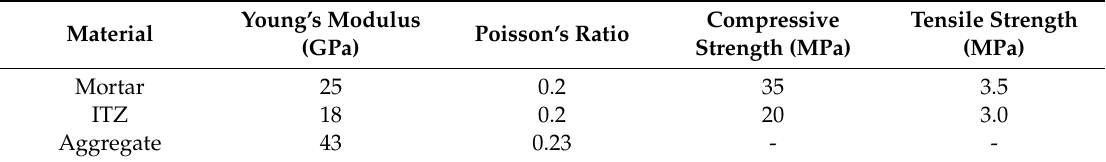
Table 5. Material parameters of three-phase materials.